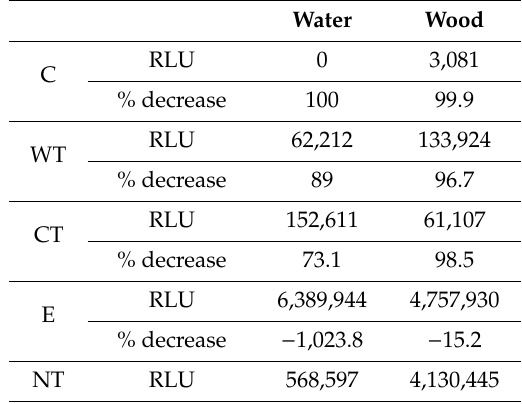
Table 5. Evaluation of the biocidal activity of the EOs MIC through ATP bioluminescence assays carried out on storage water and on WAW samples. % decrease was calculated comparing the ATP values obtained for the di ff erent treatments with not-treated control (C: cinnamon; WT: wild thyme; CT: common thyme; E: ethanol; NT: not-treated control). Water Wood RLU 0 3,081 C % decrease 100 99.9 RLU 62,212 133,924 WT % decrease RLU CT